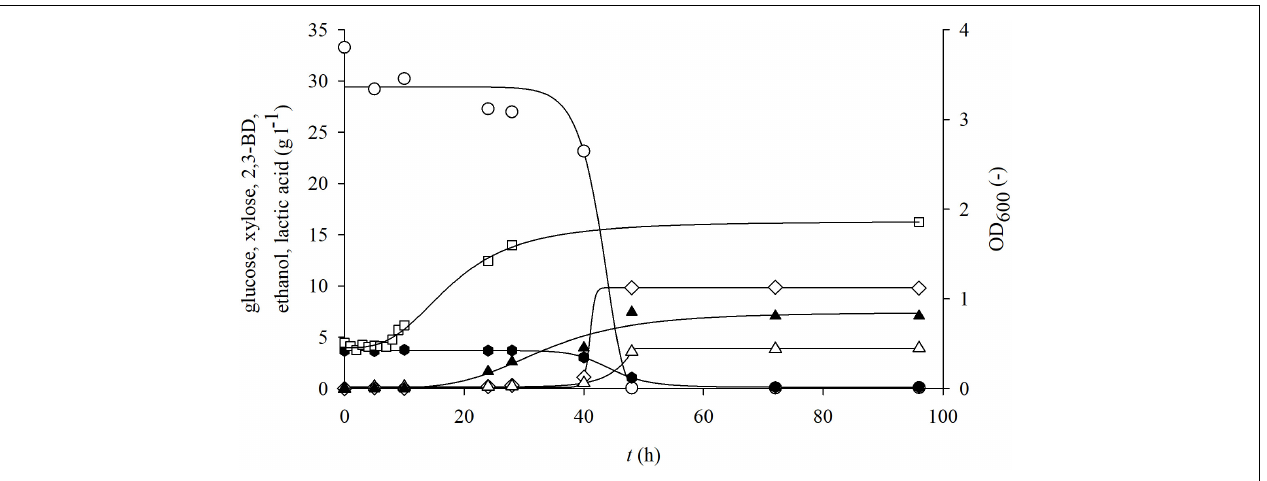
FIGURE 6 | Changes in optical density (OD 600 , (cid:3) ) and concentration of glucose ( (cid:13) ), xylose ( ), 2,3-BD ( (cid:5) ), ethanol ( (cid:52) ), and lactate ( (cid:78) ) during cultivation of bacterium P. polymyxa DSM 742 in media with liquid phase of detoxified dilute acid BSG hydrolysate in the stirred tank bioreactor.